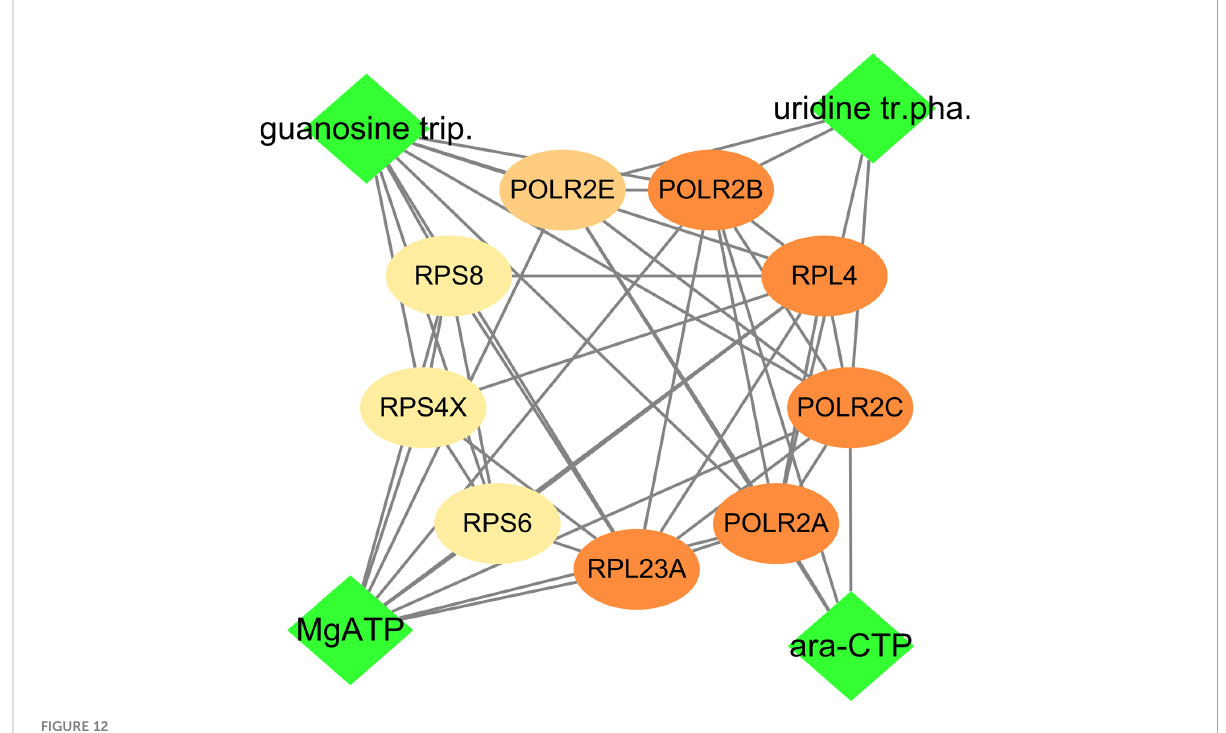
FIGURE 12 Drug-hub gene interacvtion. Green rhombus is medicine, and ellipse is gene including POLR2B, RPS6 and RPL23A.